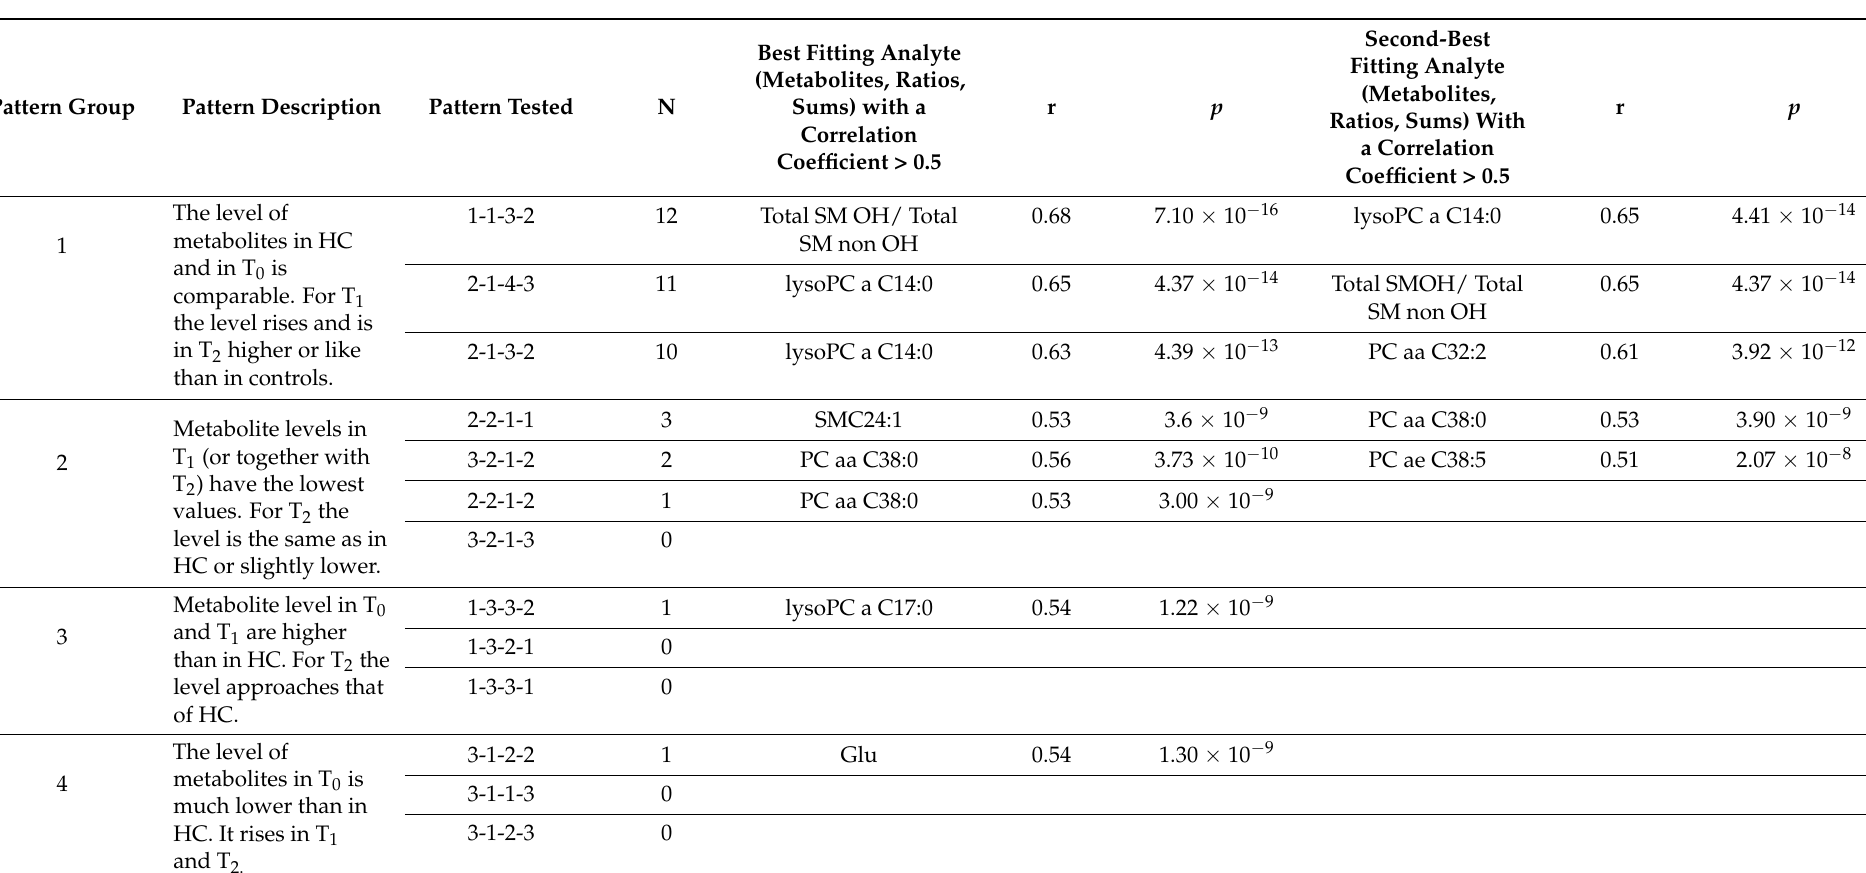
Table 3. Examined patterns of concentrations of metabolites (or their ratios) in healthy controls (HC) and in T 0 , T 1 and T 2 . Results are grouped according to pattern motives. The most populated individual pattern is ranked highest within each group. The most frequent pattern of all was “1-1-3-2” (=”HC”-“T 0 ”-“T 1 ”-“T 2 ”) which was observed for twelve different analytes.